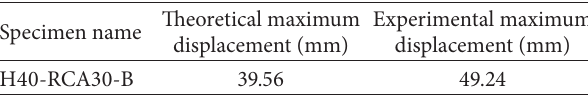
Table 8: Comparative analysis of H40-RCA30-B.